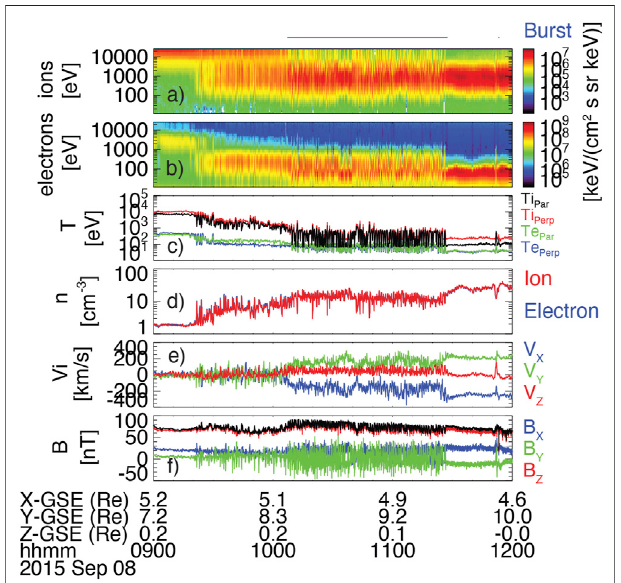
FIGURE 1 | MMS survey data during the September 8, 2015 KHI event: (A) Ion omni-directional energy spectra, (B) electron omni-directional energy spectra, (C) electron and ion temperatures perpendicular (Perp) and parallel (Par) to the background magnetic fi eld, (D) ion and electron number density, (E) ion bulk velocity in GSE coordinates, (F) magnetic fi eld vector in GSE coordinates.